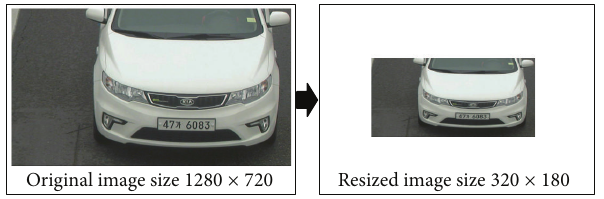
Figure 12: Resized image from the original image.